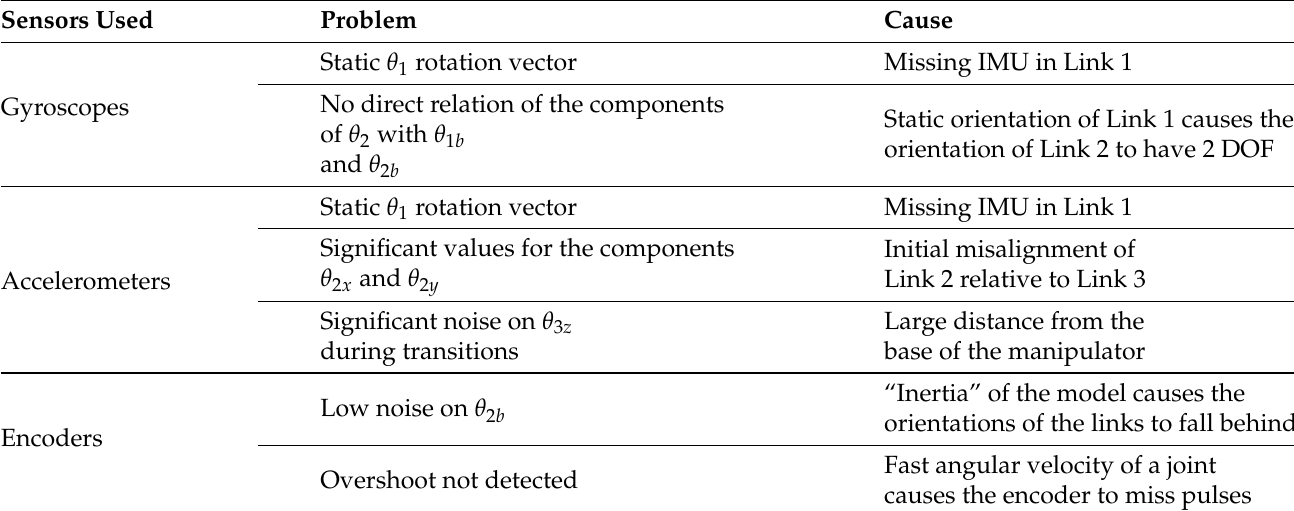
Table 3. Summary of the errors of the link model using individual sensors.